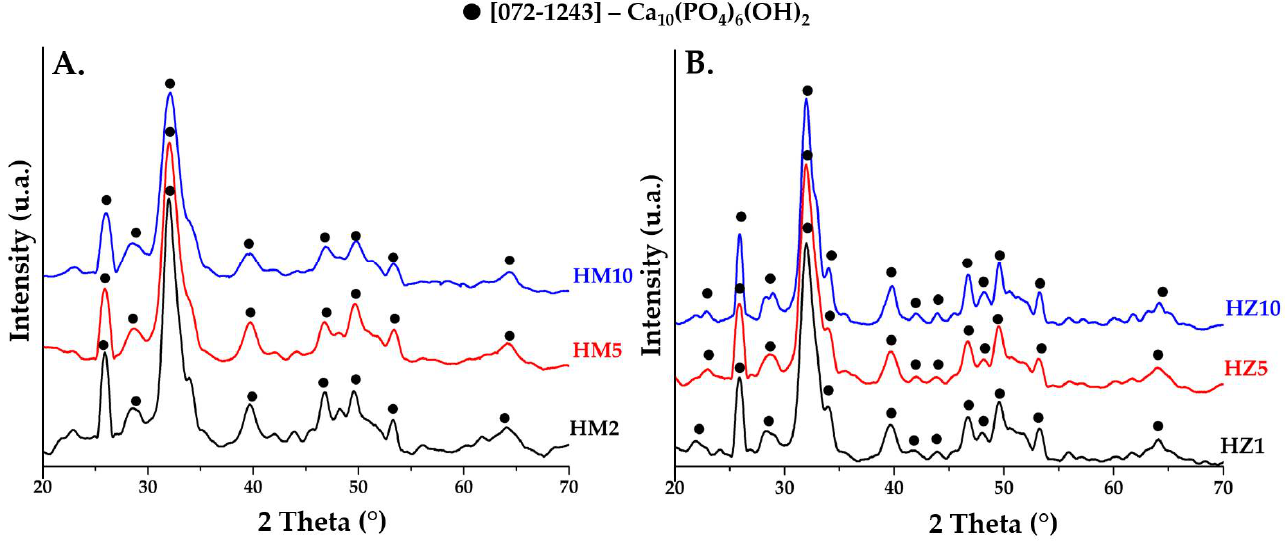
Figure 2. XRD patterns of precipitates obtained after the drying process at 80 °C for ( A ) powders doped with magnesium (HM2, HM5, and HM10) and ( B ) powders doped with zinc (HZ1, HZ5, and HZ10) .